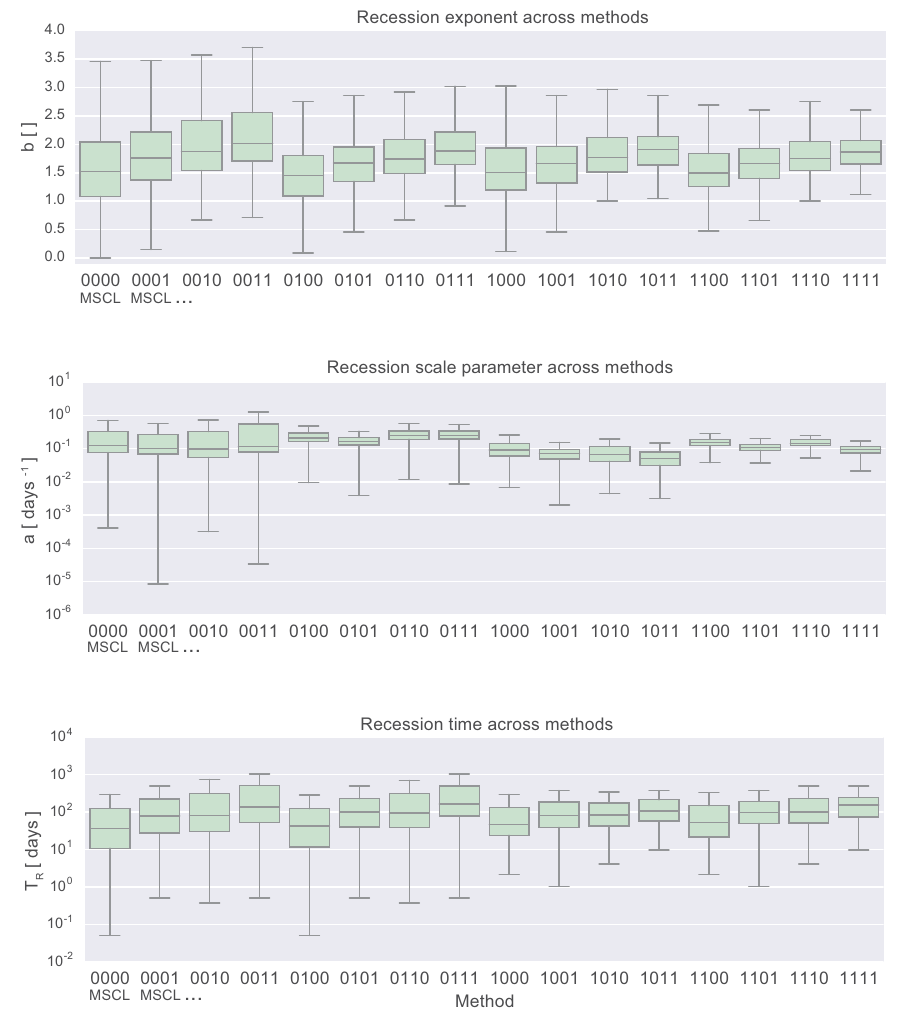
Figure 8. Box plots for a , b , and T R across all method combinations for Elder Creek